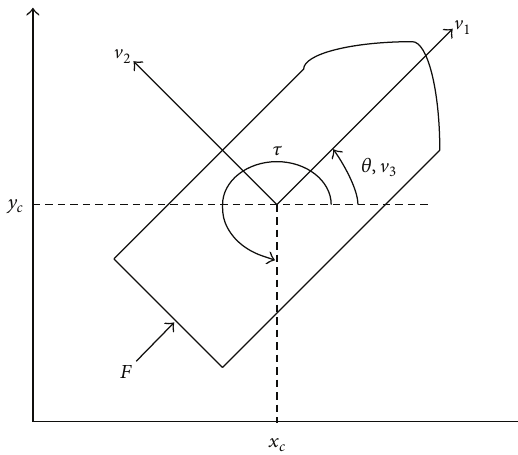
Figure 1: Actuator diagram for an underactuated underwater vehicle in horizontal